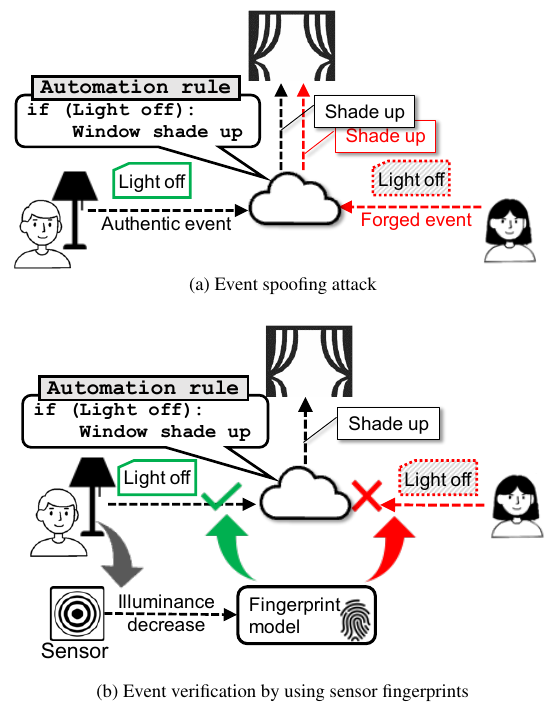
Fig. 1 Examples of event spoofing attack and its defense solution. Fig. 2 Sensor data fluctuation caused by